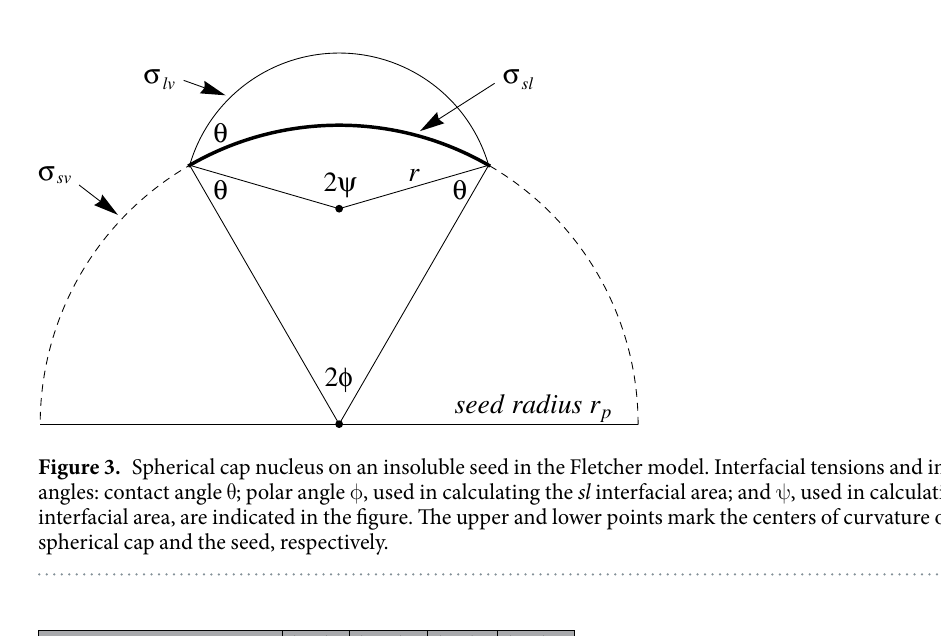
where ν l is average volume per molecule in the bulk liquid phase. Remarkably, the contact angle θ can now be obtained directly from nucleation probability measurements for S known seed particle radius r p , as described in ref. 7 . The approach begins with the volume ratio, cap to spherical drop having the same radius of curvature r * 17 :